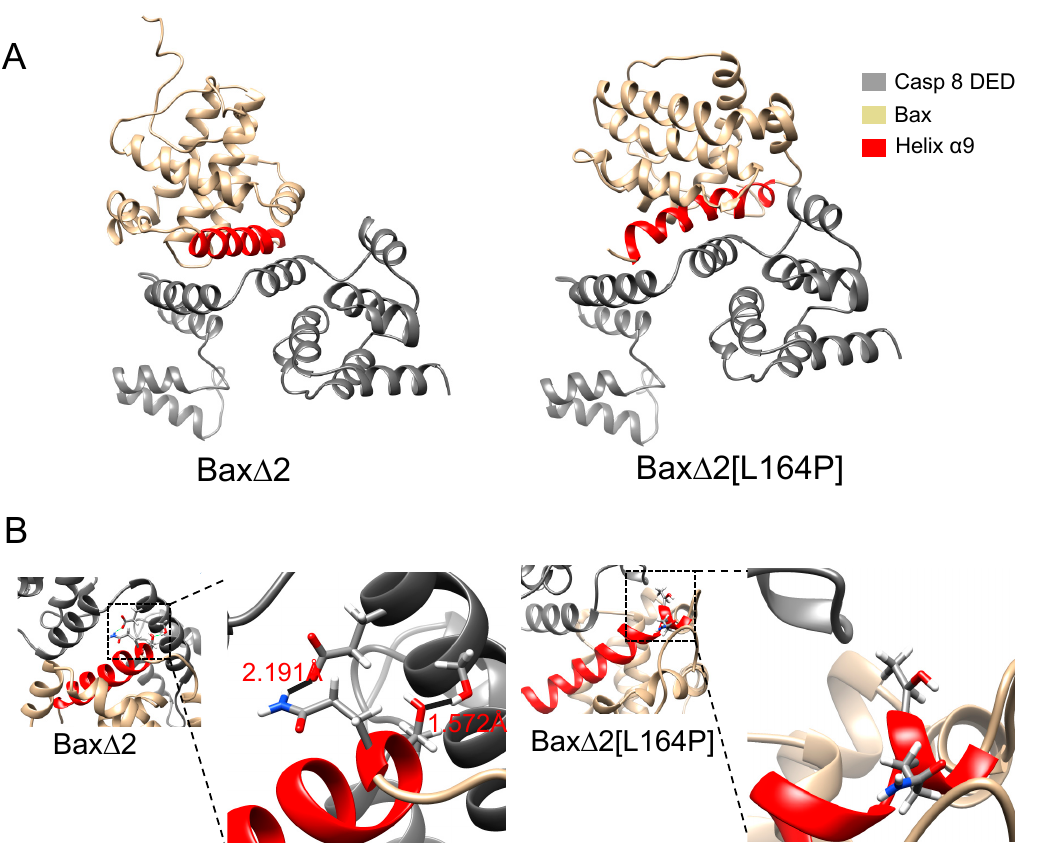
Figure 7. Protein–protein docking poses. ( A ) The lowest-energy binding pose of Bax ∆ 2 with caspase 8 ( left ). The lowest-energy binding pose of Bax ∆ 2 [L164P] with caspase 8 ( right ). ( B ) Details of Bax ∆ 2 binding ( left ) and Bax ∆ 2[L164P] binding ( right ). In all panels, Bax ∆ 2 is colored gold, helix α 9 red, and the caspase death effector domain (DED) grey.